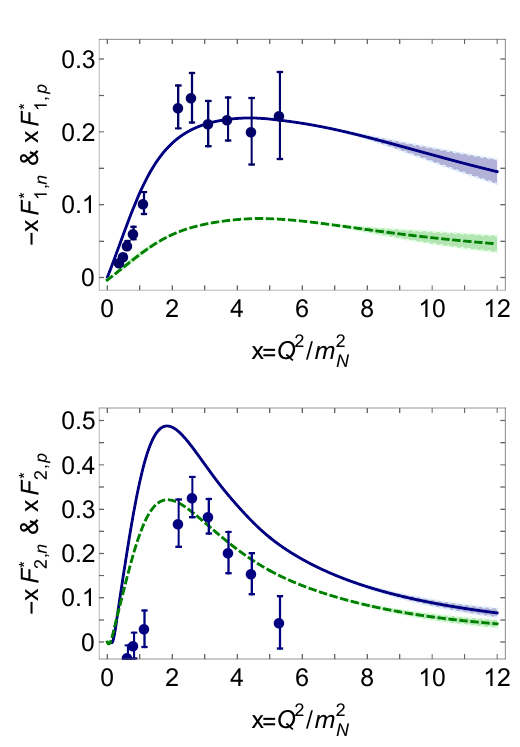
Figure 9. Computed x -weighted Dirac (upper panel) and Pauli (lower panel) transition form factors for the reactions γ ∗ p → R + (solid blue curves) and γ ∗ n → R 0 (dashed green curves). In all cases, the results on x ∈ [6 , 12] are projections, obtained via extrapolation of analytic approximations to our results on x ∈ [0 , 6]: at each x , the width of the band associated with a given curve indicates our confidence in the extrapolated value. (See text for details.) Data in both panels are for the charged channel transitions, F ∗ and F ∗ : circles (blue) [42]. No data currently 1 , p 2 , p exist for the neutral